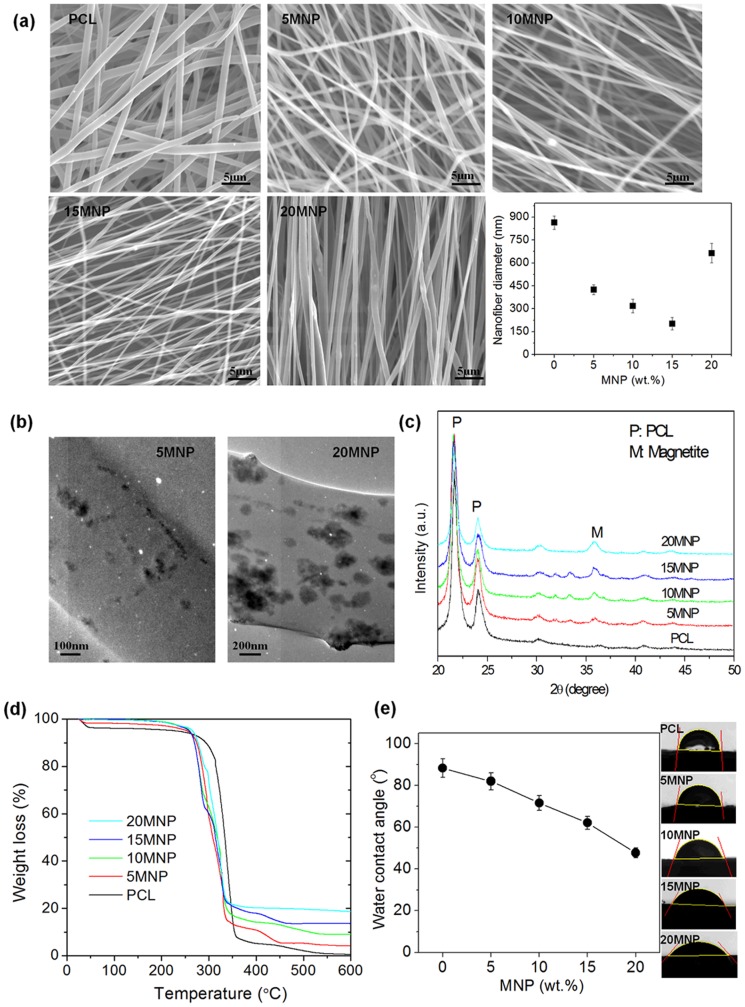
Morphological and behavioral analyses of MNPs.(a) SEM morphology of the electrospun nanofibers with different compositions (PCL or its nanocomposite with MNPs at varying concentrations; 5% ‘5MNP’, 10% ‘10MNP’, 15% ‘15MNP’ and 20% ‘20MNP’) and the nanofiber diameter measurement. (b) TEM image shows the internal structure revealing nanoparticles present in the nanofiber (‘10MNP’ and ‘20MNP’). (c) XRD patterns of the nanocomposite nanofibers. (d) TGA results of the weight loss of samples during thermal treatment. The remained weight was 4.1, 9.0, 13.6 and 18.6%, respectively, for 5MNP, 10MNP, 15MNP and 20MNP, demonstrating slightly lower values than but well matching to the amounts initially added to the nanocomposite solutions. (e) Wettability test of the nanofiber scaffolds using a contact angle tester, showing significant improvement in wettability (contact angle decrease) with incorporation of MNPs.